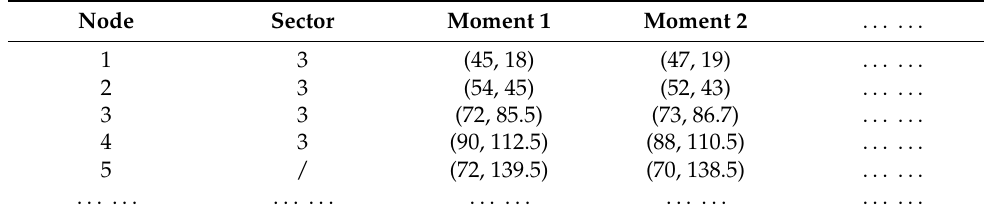
Table 1. Aircraft node coordinates.